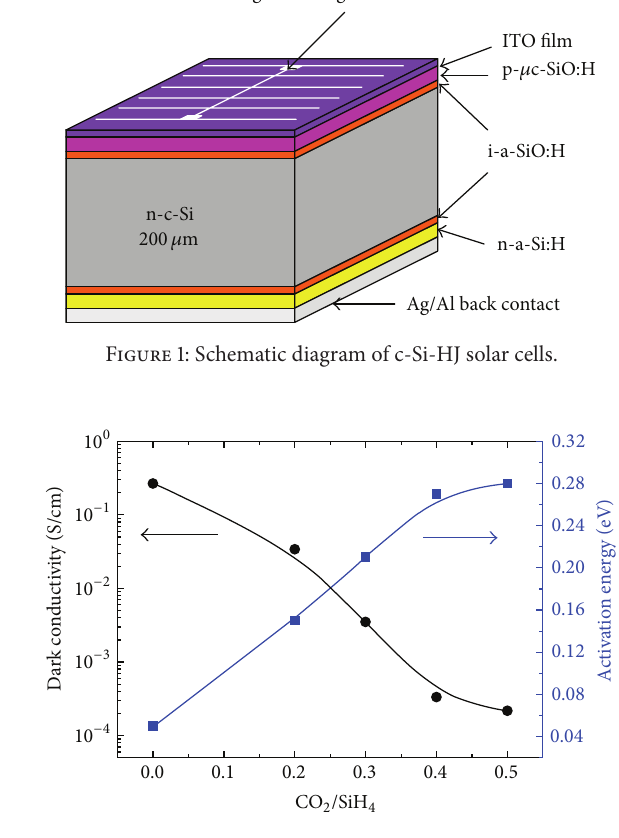
Figure 2: Dark conductivity ( 𝜎 𝑑 ) (indicated by e ) and activation energy ( E 𝑎 ) (indicated by ◼ ) of p- 𝜇 c-SiO:H films as a function of the CO 2 /SiH 2 ratio. The lines are a guide to the